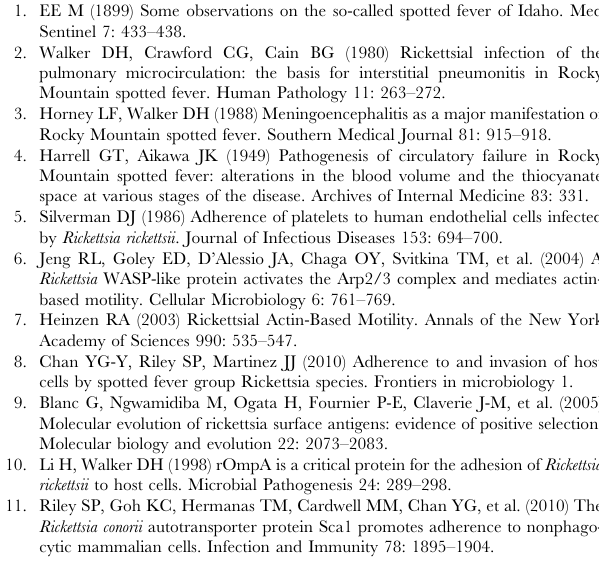
Table S1 Primer sequences and cleavage sites of surface-exposed proteins. Table S2 Matching ratio of five novel surface-exposed proteins in spotted fever group